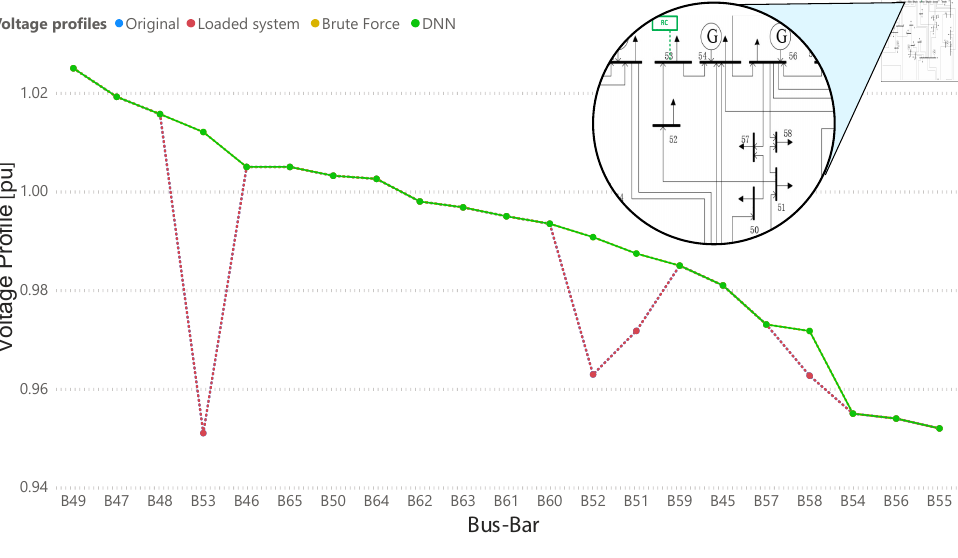
Figure 12. Voltage profiles for 188 bus-bar system: original system, loaded system, brute force results and DNN